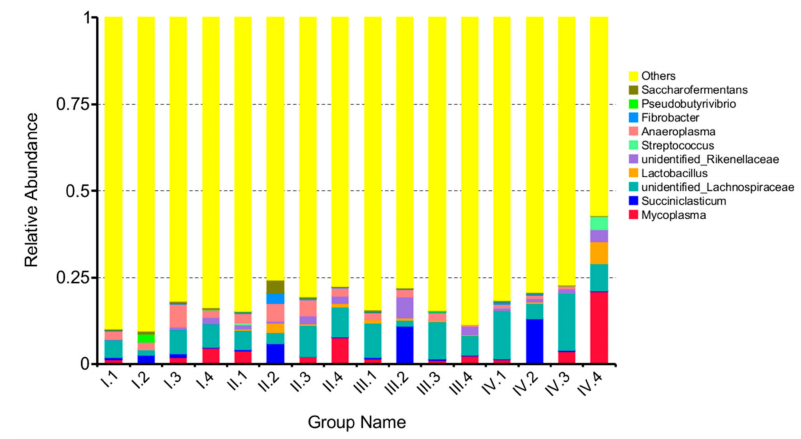
Figure 4. The column chart of the main dominant genera. A color-coded bar plot, showing the average bacterial genera distribution across four groups through four periods. Periods I (1–18 d), II (19–36 d), III (37–54 d), and IV (55–72 d). Groups 1, 2, 3, and 4 represent four groups of sheep treated with four dietary NFC / NDF ratio of 0.54, 0.96, 1.37, and 1.90.